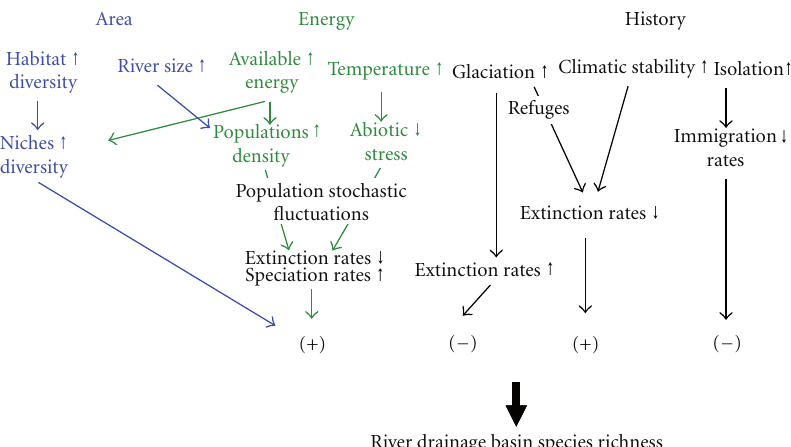
Figure 7: Potential causal pathways between environmental factors and processes a ff ecting positively (+) or negatively ( − ) the species richness of a river